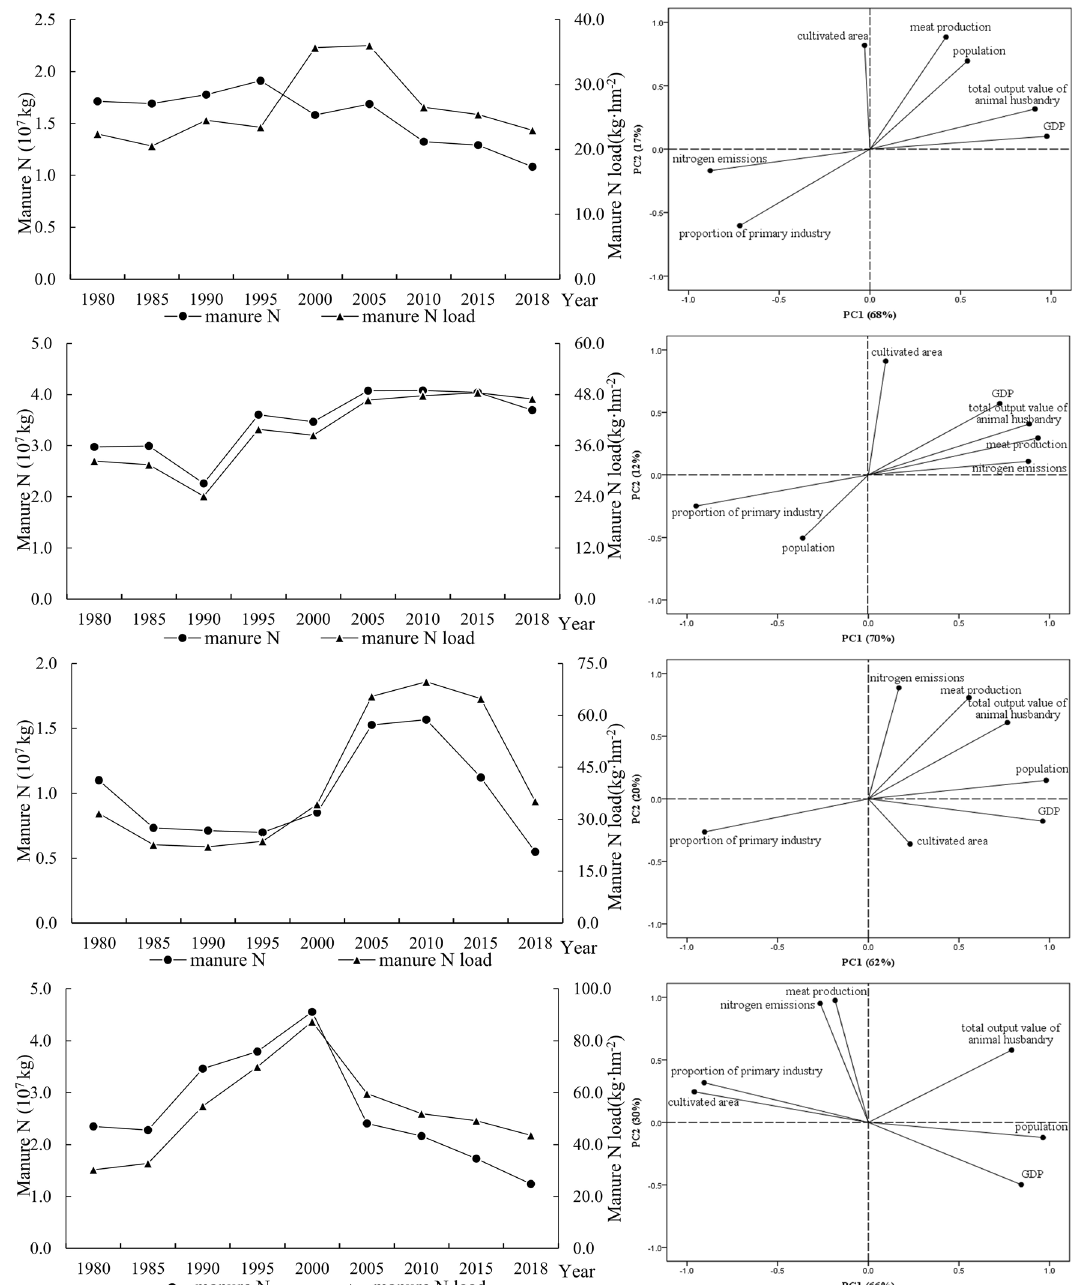
Figure 9. Manure N emissions from 1980 to 2018 and main control factors based on principal component